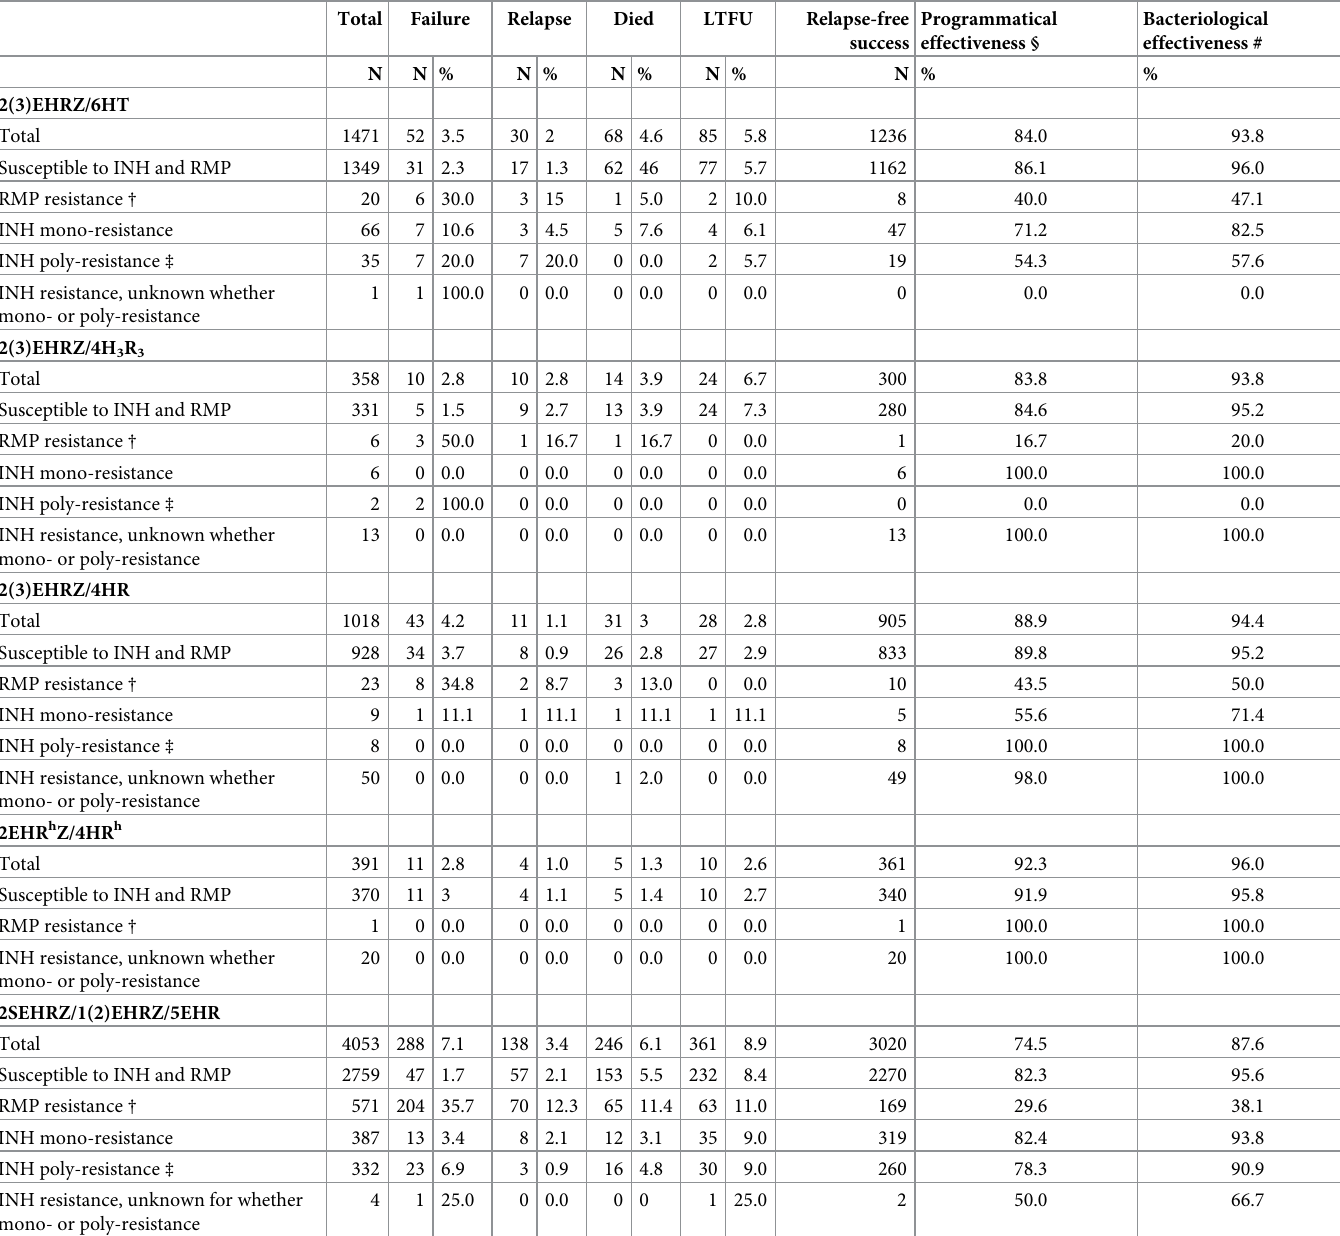
Table 1. Treatment outcomes of 7291 patients on first-line TB treatment regimens in Bangladesh, by initial resistance to rifampicin and